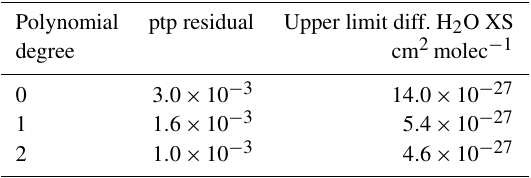
Table 4. Magnitude peak-to-peak (ptp) residual sizes and upper limits for water vapour absorption between 310 and 350nm at a spectral resolution of 0.7nm for different polynomial degrees of the DOAS